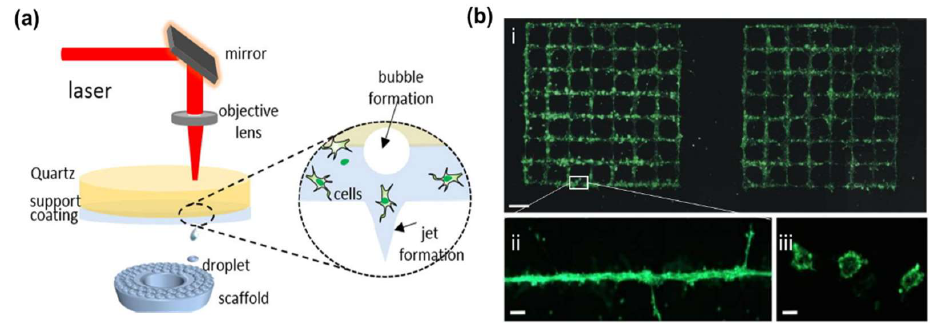
Figure 4. ( a ) Laser-assisted bioprinting based on laser-induced forward transfer. Adapted from Ref. [33]. ( b ) Green fluorescent labeled endothelial cells printed in the patterns ( i ) of grids on Matrigel, ( ii ) the enlarged line of (i), ( iii ) cross-sections of the printed vascular structures. Adapted from Ref. [34].